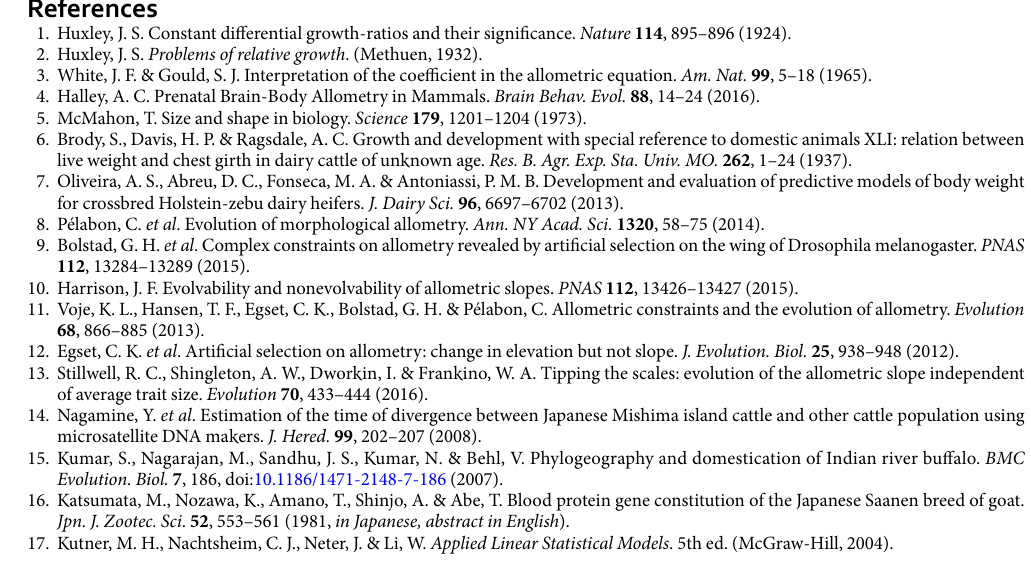
phylogenetic changes occurring on macro time scales. Figure 4 shows the relationships between allometric parameters and species divergence time. With the exception of yak, the differences in the alternative intercept